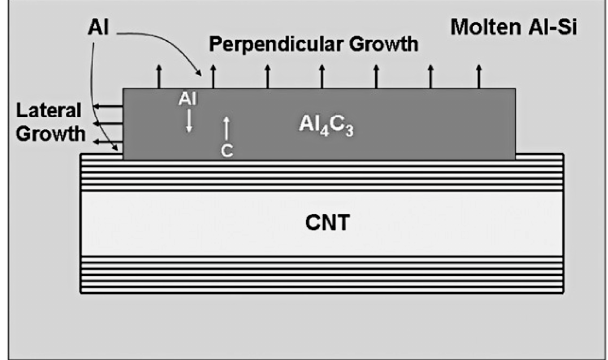
Figure 16. A schematic view of growth mechanisms of Al 4 C 3 dispersoids on CNTs. It indicate the vertical migration of Al and C atoms for the formation of Al 4 C 3 carbides [131]. (Reproduced with permission from [131], Elsevier, 2009.)